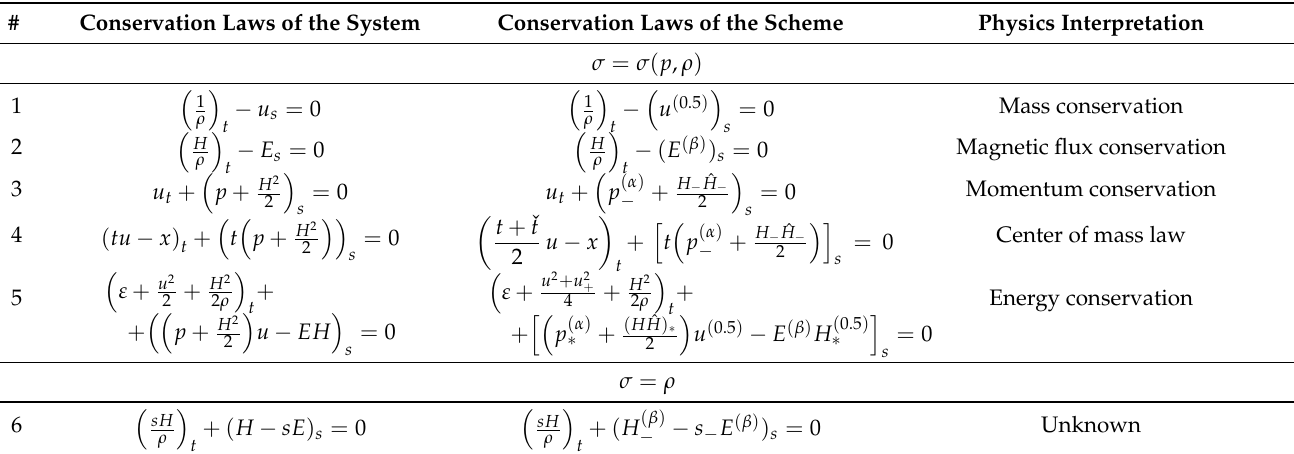
Table 1. Differential and difference conservation laws for system (18) and scheme